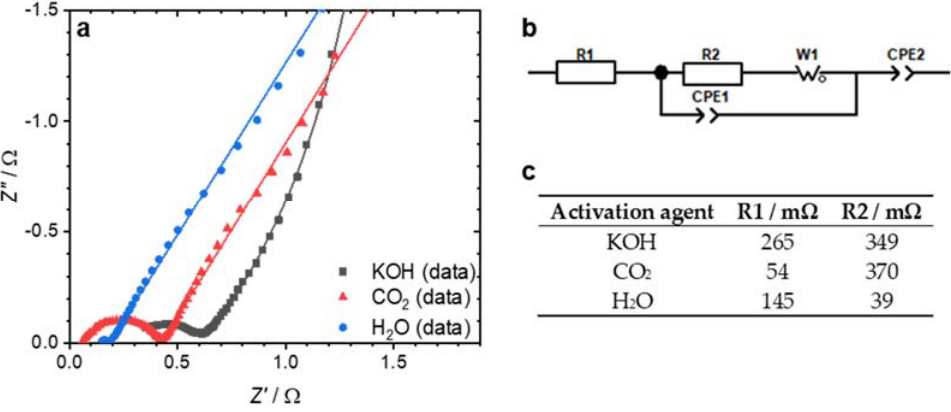
Figure 4. Nyquist plot of the EIS measurements ( a ). The symbols indicate the actual data measured; the lines represent the fit to the equivalent circuit, shown in ( b ). The table in ( c ) shows the values for resistors R1 and R2 determined by the